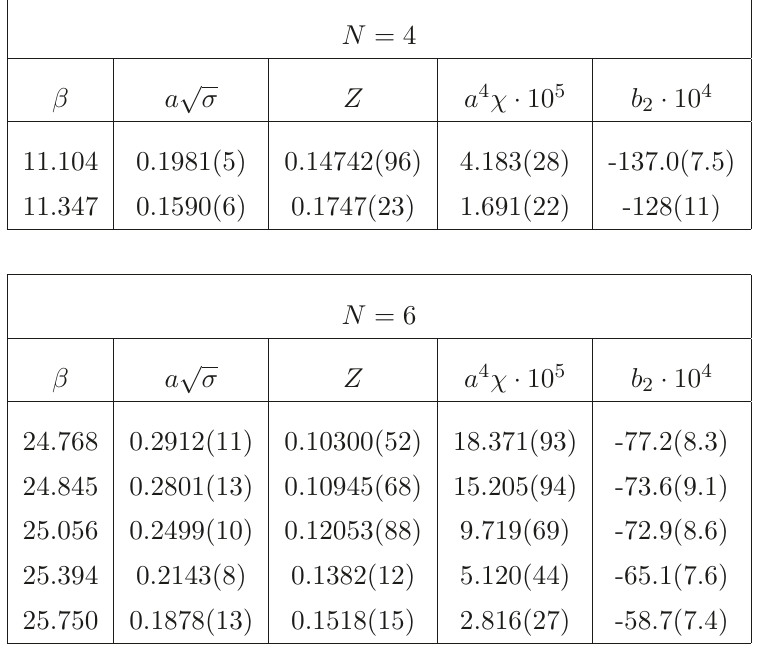
Table 3 . Summary of the results obtained using the imaginary- θ fit for N = 4 and 6 by considering up to O ( θ 4 ) terms in the Taylor expansion of the vacuum energy, i.e., neglecting b 4 in eqs. (2.7). L